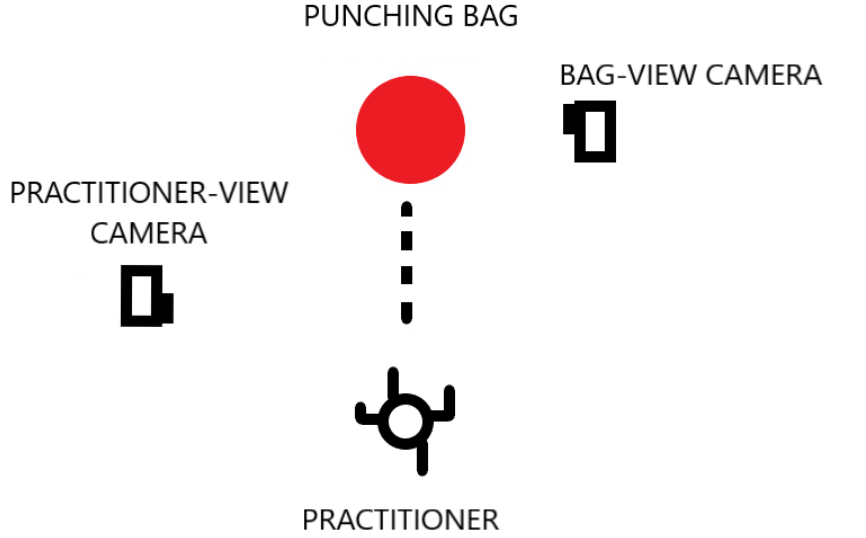
Figure 6. Vision sensing system camera experiment